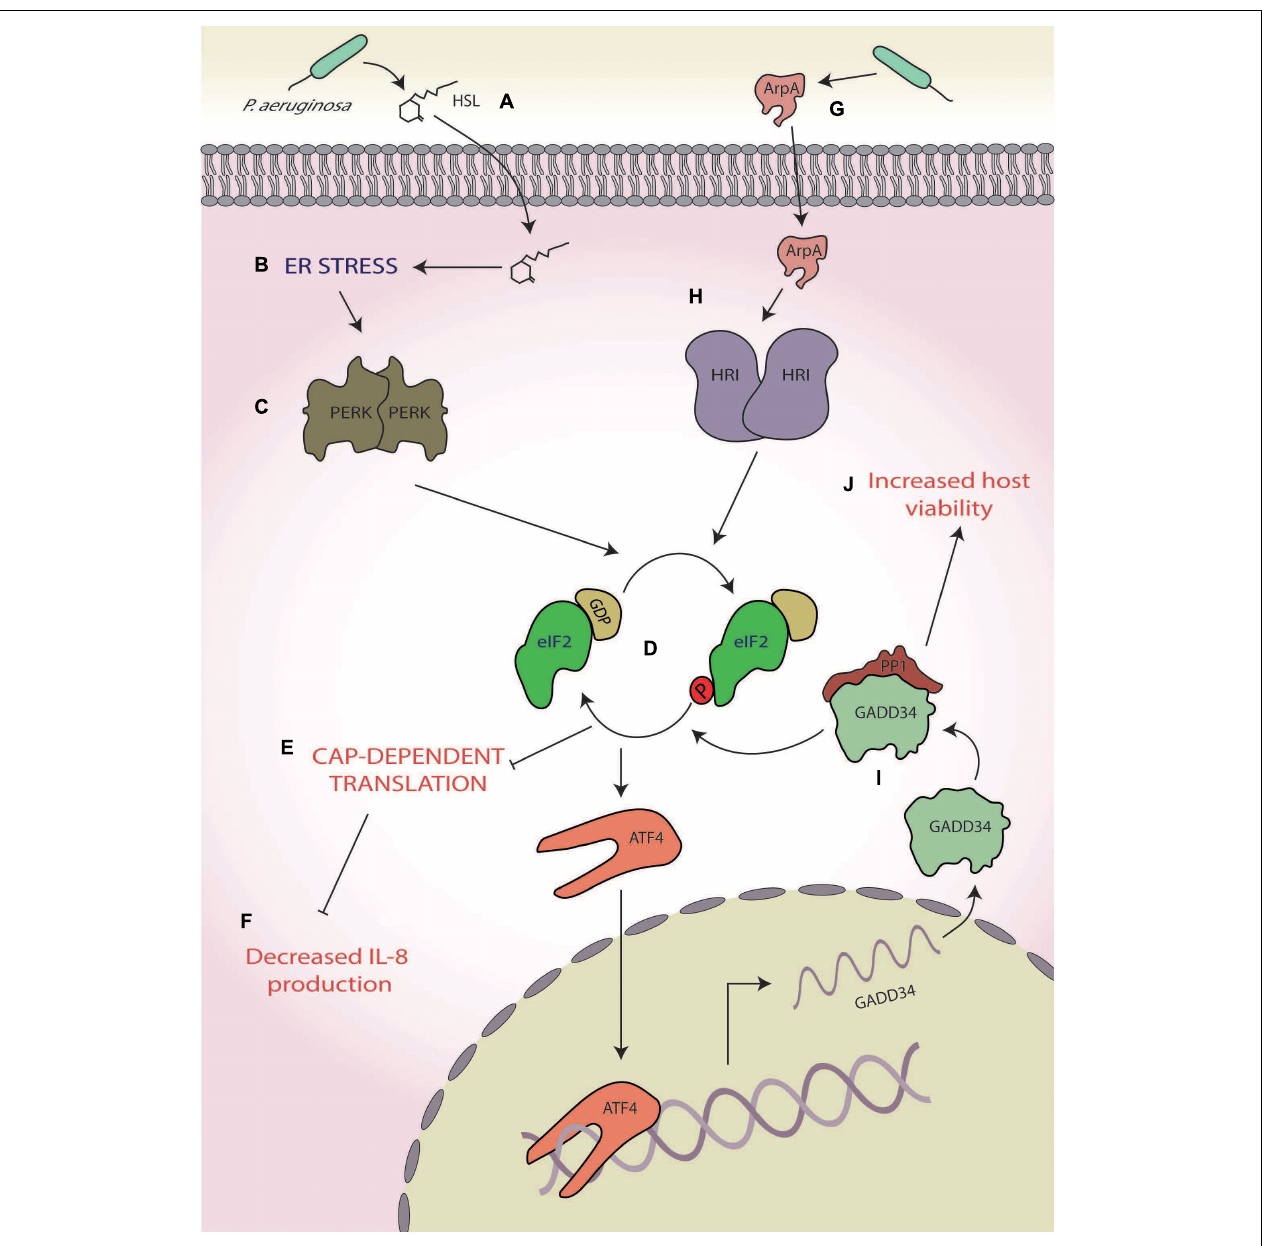
FIGURE 5 | Pseudomonas aeruginosa . (A) The quorum-sensing molecule N -(3-oxododecanoyl)-homoserine lactone (HSL) secreted by P. aeruginosa (B) induces endoplasmic reticulum (ER) stress, (C) activating protein kinase R-like ER kinases (PERKs), and (D) which leads to eukaryotic initiation factor 2 alpha (eIF2 α ) phosphorylation. (E) The consequential translational stalling (F) results in decreased expression of the pro-inflammatory cytokine interleukin 8 (IL-8) production. (G) A protease, alkaline protease A (ArpA), secreted by P. aeruginosa (H) activates heme-regulated inhibitor (HRI), (I) leading to the specific upregulation of growth arrest and DNA damage-inducible protein (GADD34), and (J) which increases host cell viability.